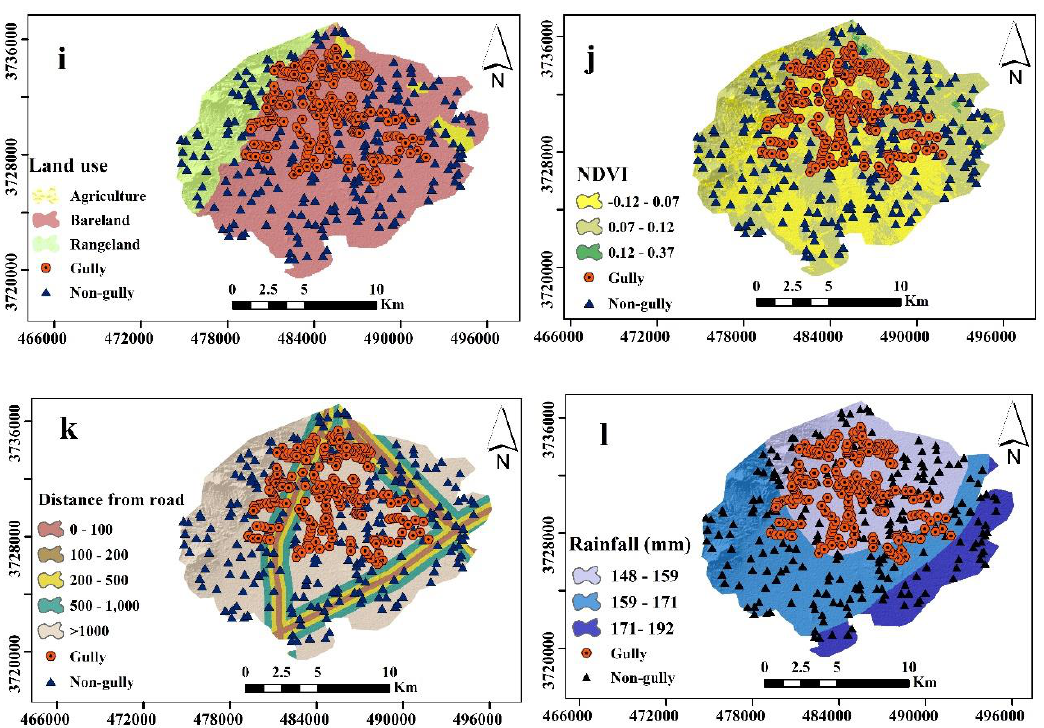
Figure 4. Spatial database for gully susceptibility analysis. ( a ) Elevation, ( b ) aspect, ( c ) slope, ( d ) plan curvature, ( e ) profile curvature, ( f ) distance from river, ( g ) drainage density, ( h ) lithology, ( i ) land use, ( j ) NDVI, ( k ) distance from road, ( l ) rainfall.